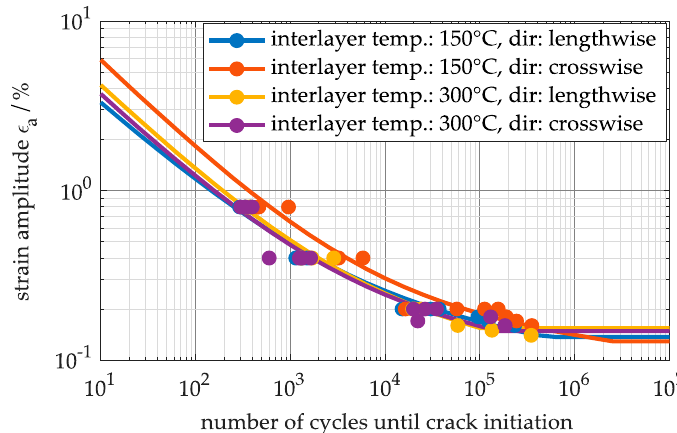
Figure 11. Cyclic stress–strain curves from strain-controlled tests.